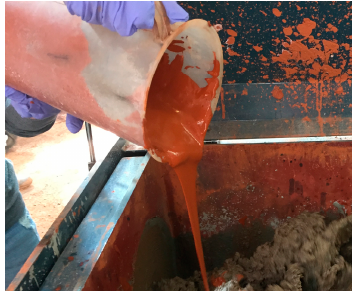
Figure 3. Liquefied red mud (LRM).